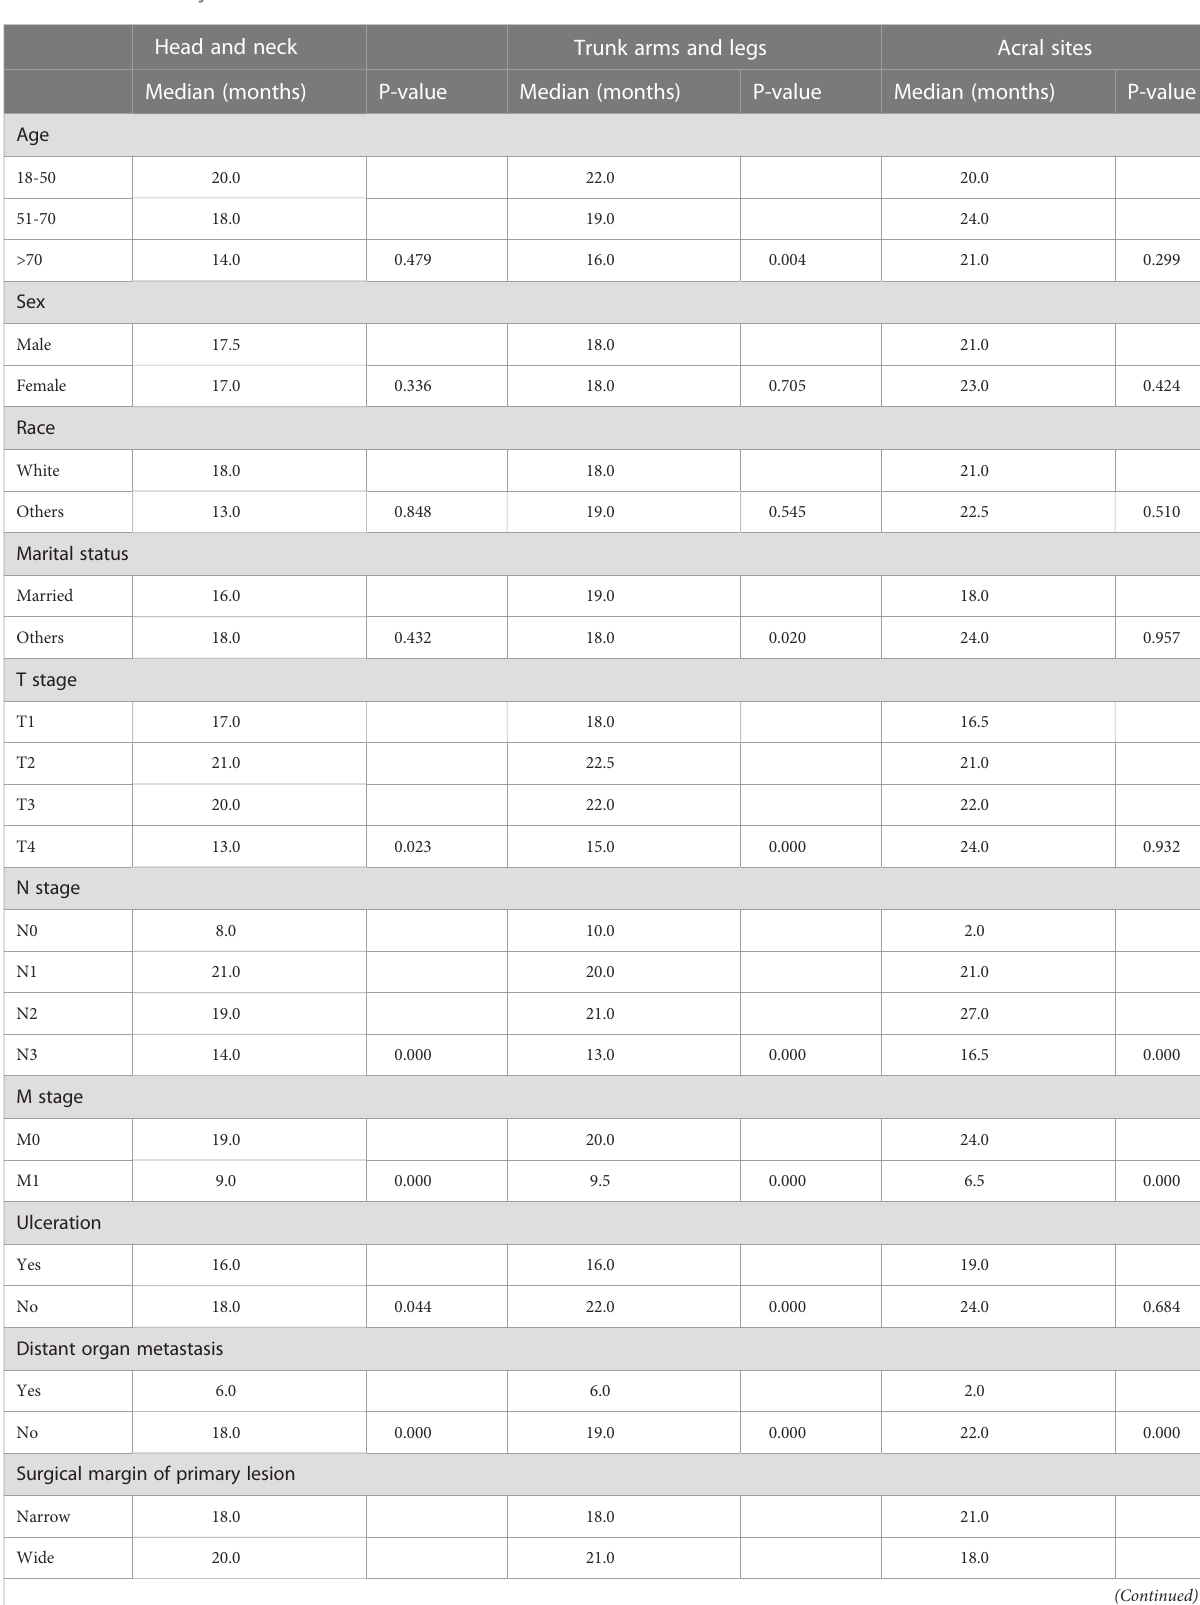
TABLE 3 Strati fi ed analysis of cohorts in the ICIS